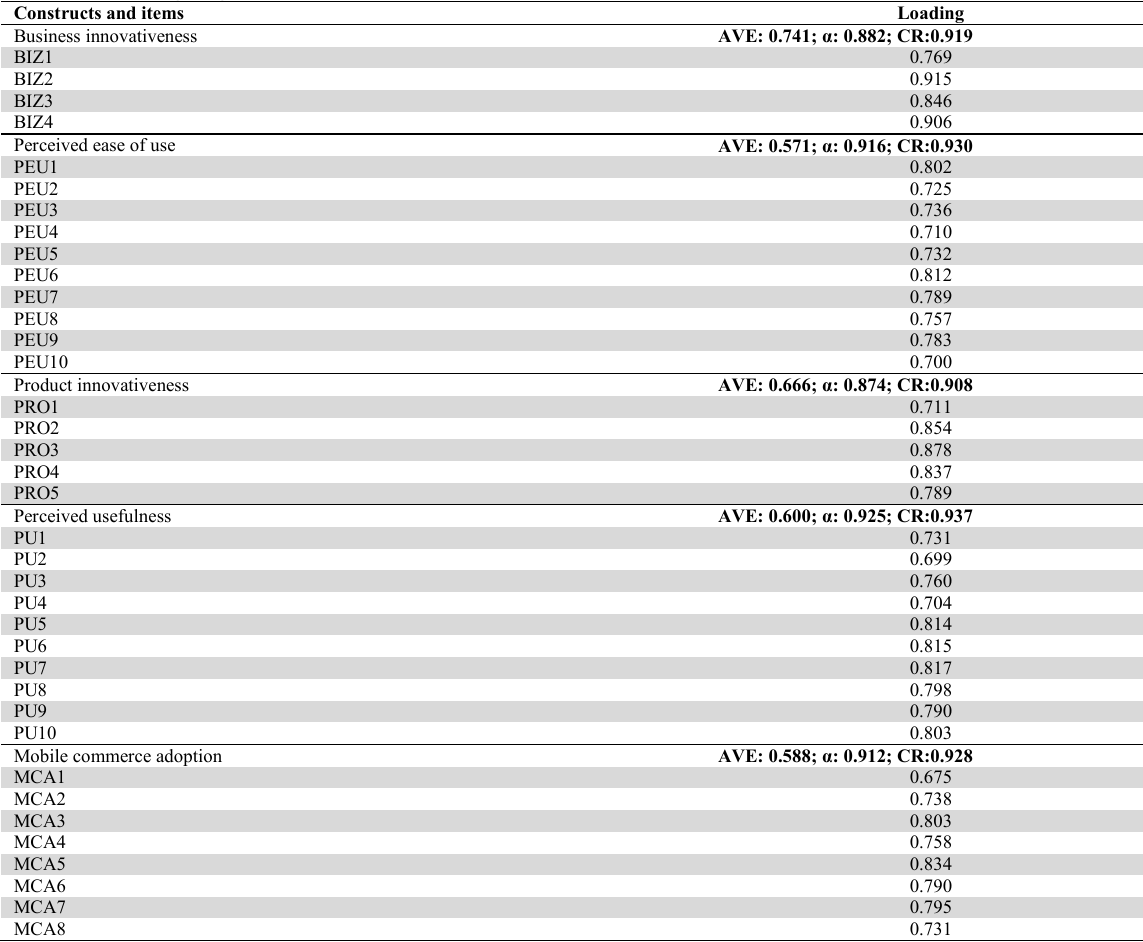
Factors Loading Significance Constructs and items